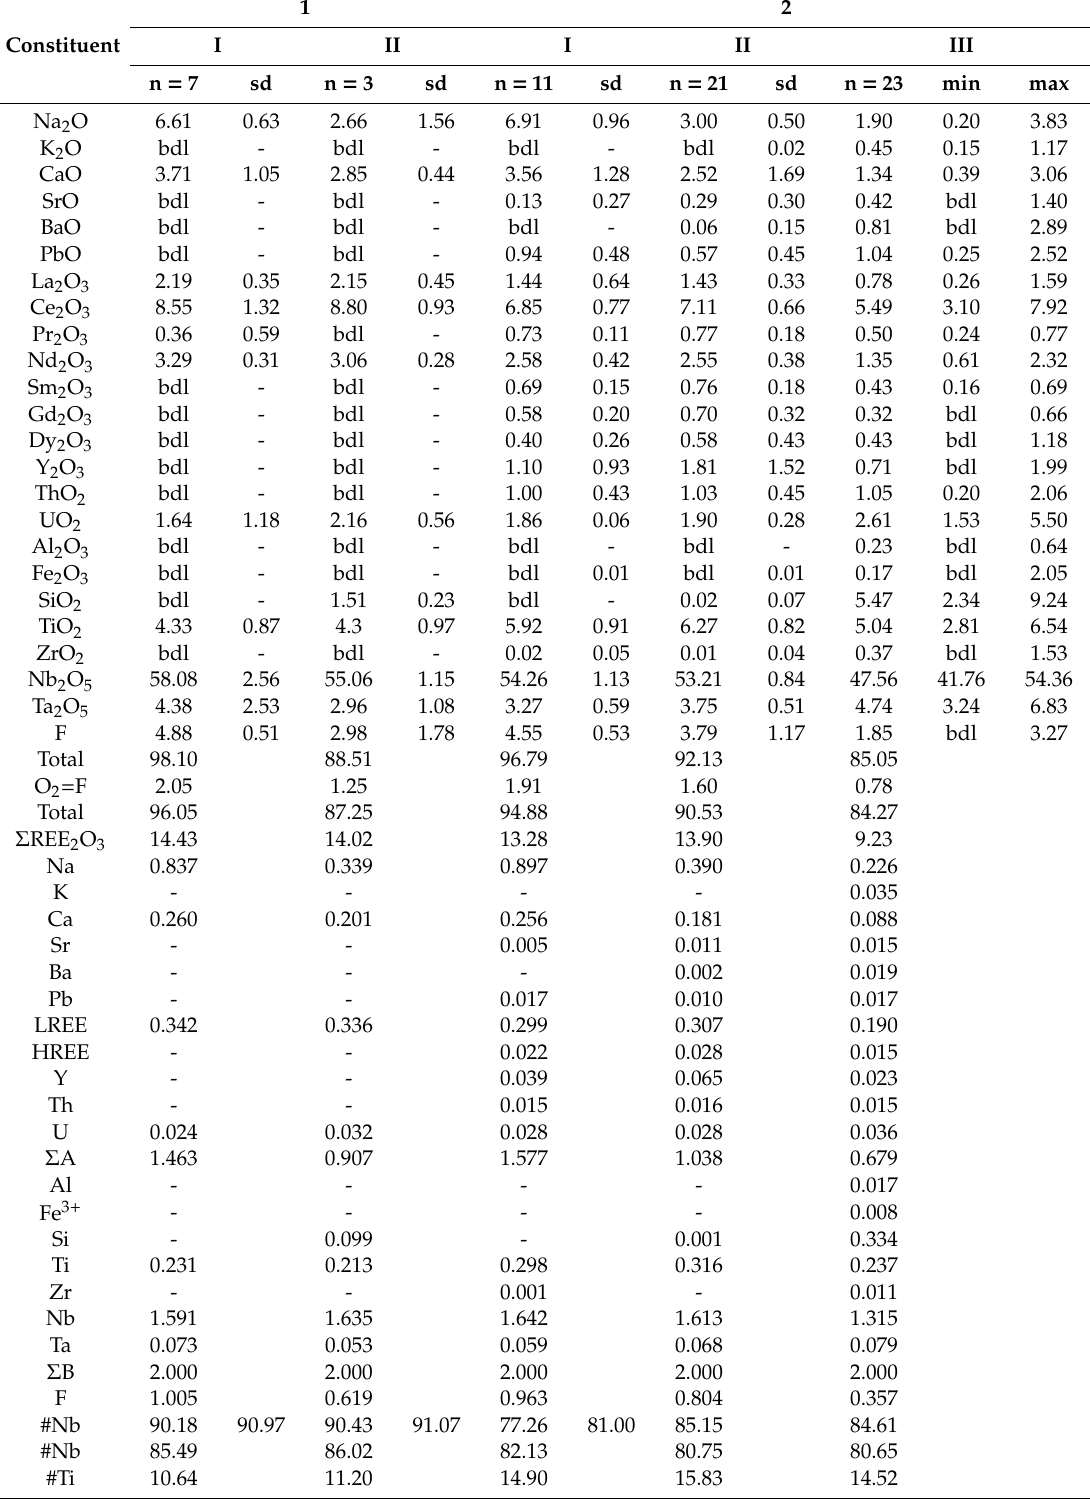
Table 2. Chemistry (wt.%) of pyrochlore-group minerals from the Katugin biotite and biotite-riebeckite granites (1) and arfvedsonite aegirine-arfvedsonite granites